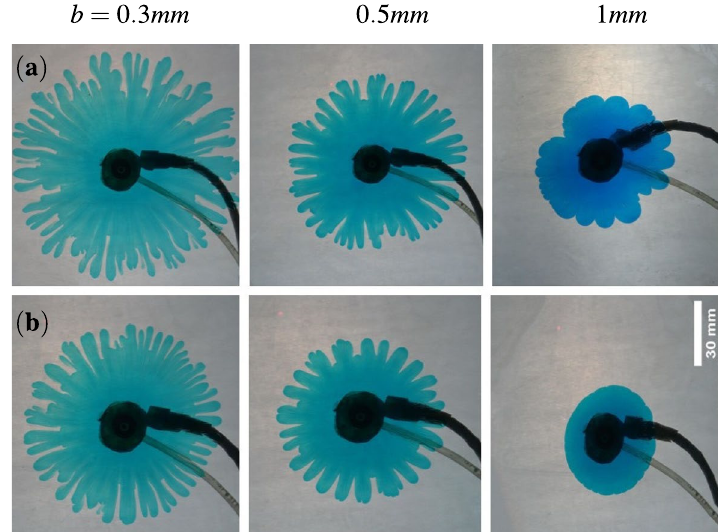
Figure 3. The fingering patterns for M = 3 at t = 10 s and different flow rate, ( a ) Q = 0.2 mL/s , ( b ) Q = 0.1 mL/s . The instability abates with an increase in the gap from left to right.